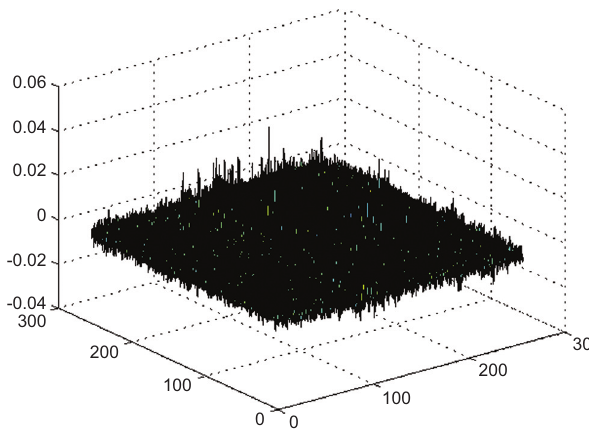
Figure 20. Surf Plot of Phase Correlation for Test Image1.